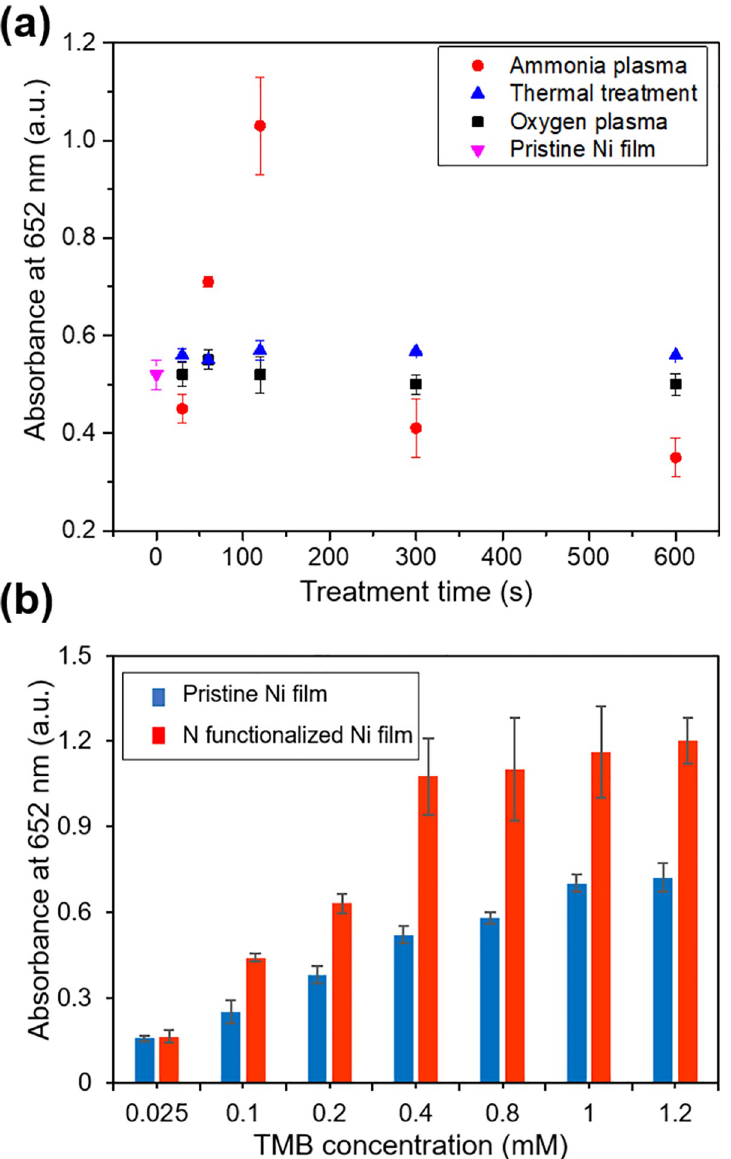
Fig 5. (a) Comparison of absorbance at 652 nm for equivalent TMB solutions oxidized by Ni GLAD films that were exposed to ammonia plasmas (red circles), oxygen plasmas (black squares) and plasma-free thermal treatments at 350˚C (blue triangles) for various lengths of time. The original reaction solutions were always 525 μ l (0.4 mM TMB and 470 mM H 2 O 2 ), and the oxidation process was allowed to proceed for 15 minutes. (b) Comparison of absorbance at 652 nm for pristine Ni films and N-functionalized Ni films exposed for 120s to different concentrations of